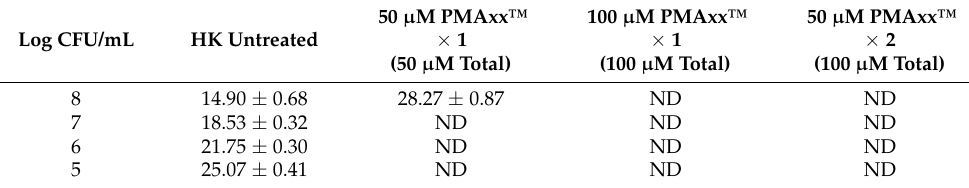
Table 2. Average Ct values for PMAxx™ treatments * on HK cells (without tube